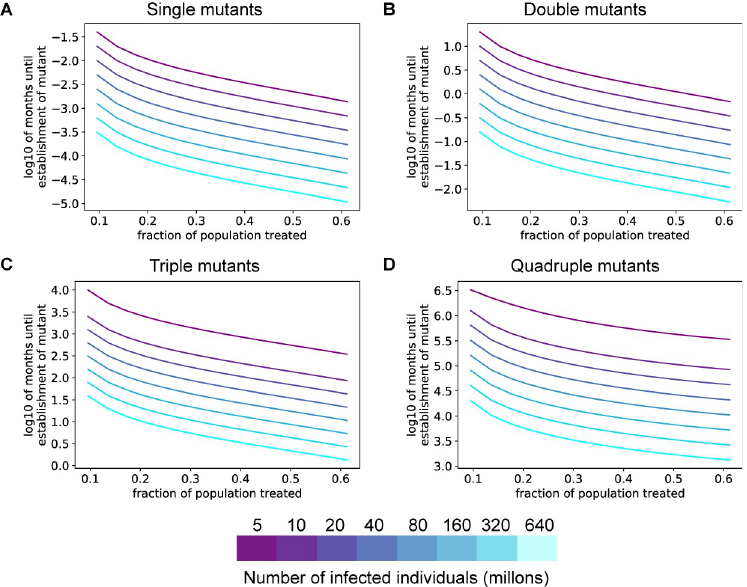
Fig 4. Resistance to single or double antibody combinations will develop quickly under positive selection pressure. A-D. Expected time to establishment of a successful single ( A ), double ( B ), triple ( C ), or quadruple ( D ) immune escape mutant assuming a per-site per-transmission mutation rate of 1x10 -4 . The advantageous antibody resistant phenotype is acquired only after a specific combination of 1–4 mutations is present in the same virus. For all panels, the colors denote the total number of individuals with active SARS-CoV-2 infection. The fitness cost for each intermediate mutant is 0.05.